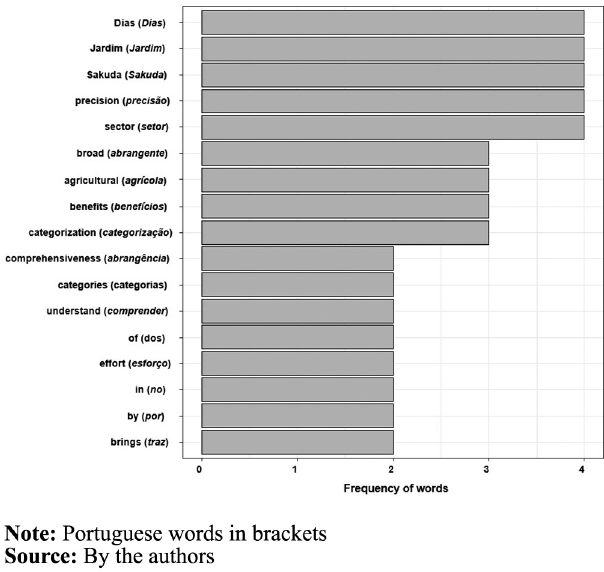
Figure 7. Frequency of the 17 the most cited words